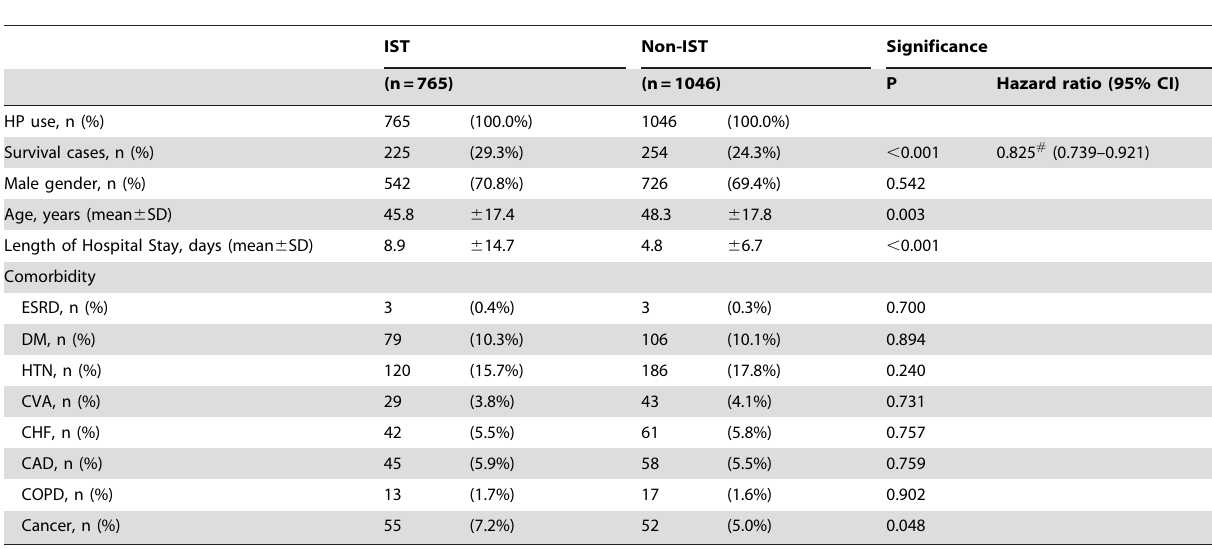
Figure 2. Kaplan-Meier survival plot of the IST group (n=765) versus the non-IST control group (n=1046, log-rank test, p , =0.001). doi:10.1371/journal.pone.0087568.g002 Table 2. Characteristics of study subjects with or without immunosuppressive